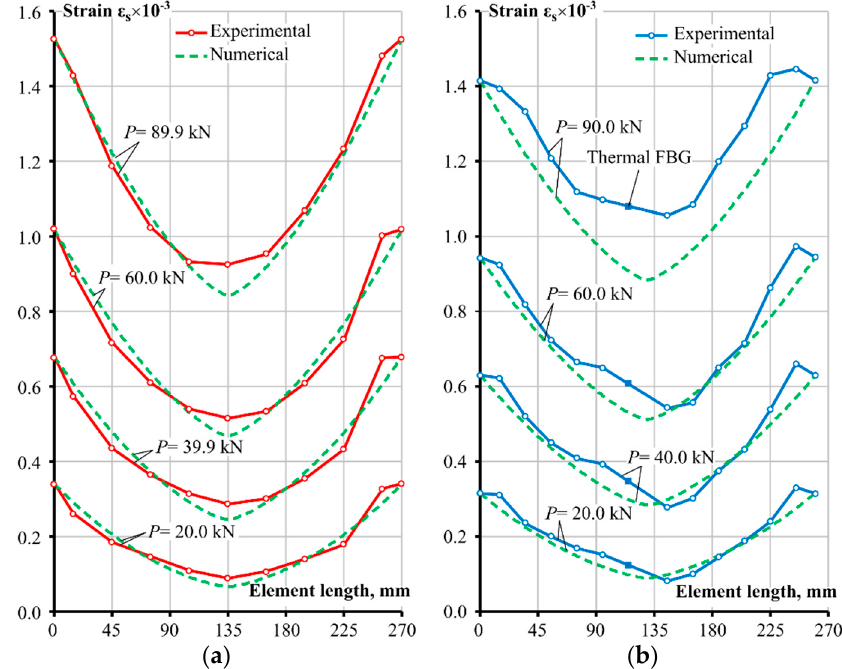
Figure 7. Predicted versus experimental reinforcement strain profiles: ( a ) Tensor strain gauge test and ( b ) FBG sensor test.